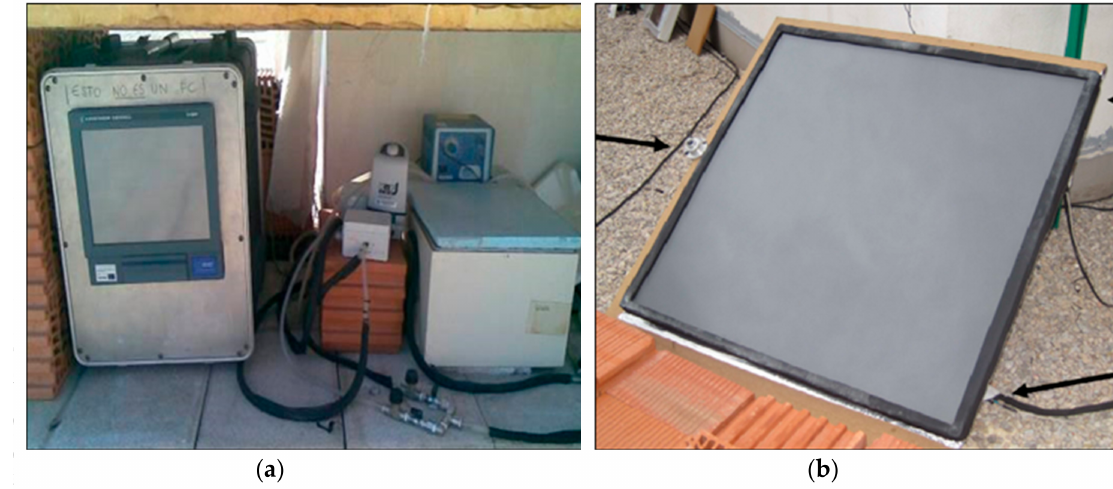
Figure 3. Experimental device used, and ceramic collector panel built for the test. ( a ) Computer and sensors; ( b ) Ceramic thermal